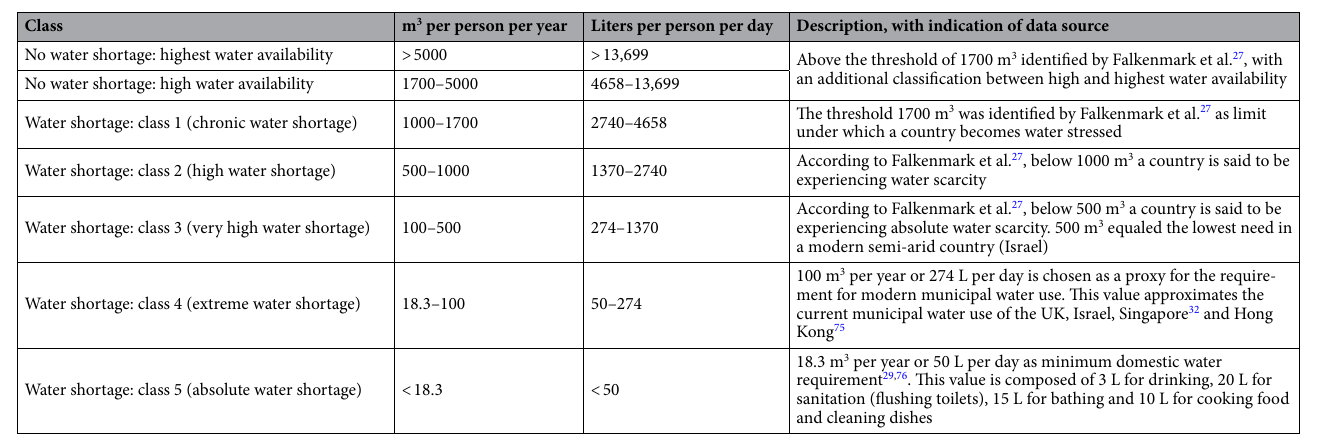
Table 2. Different renewable water availability classes, identifying water